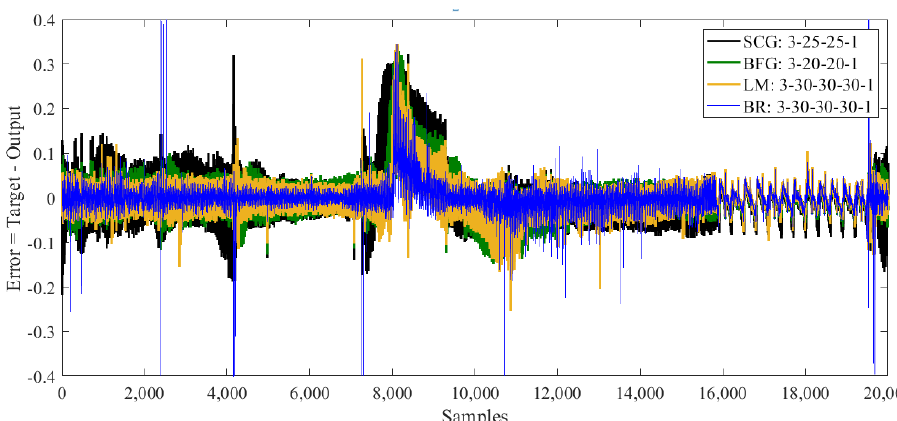
Figure 7. Predicted output results when using SCG, BFG, LM and BR.